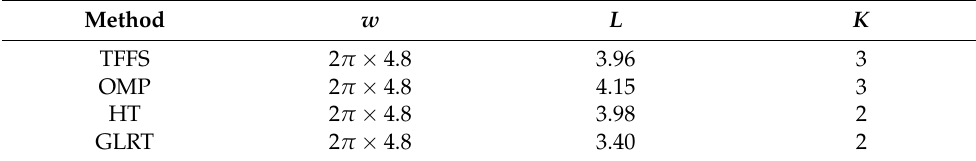
Figure 19. The processing result of the TFFS: ( a ) parameter estimation results of the TFFS; ( b ) the optimal shifted TFD. Table 4. The estimation results for the methods in the PO facet simulation model.